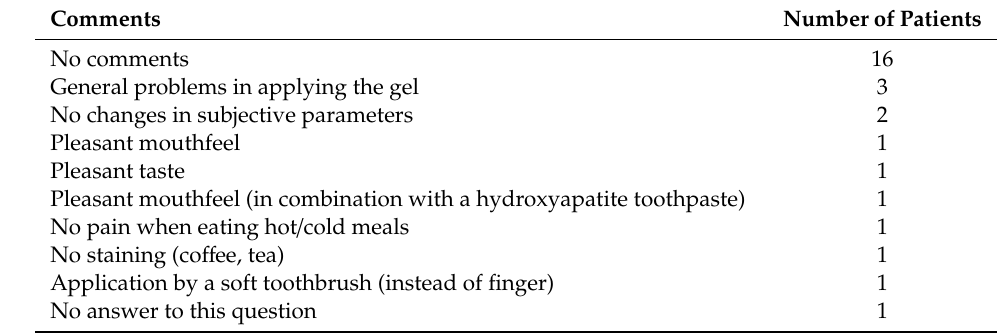
Table 4. Comments of the patients after follow-up (4-week; clustered from free text